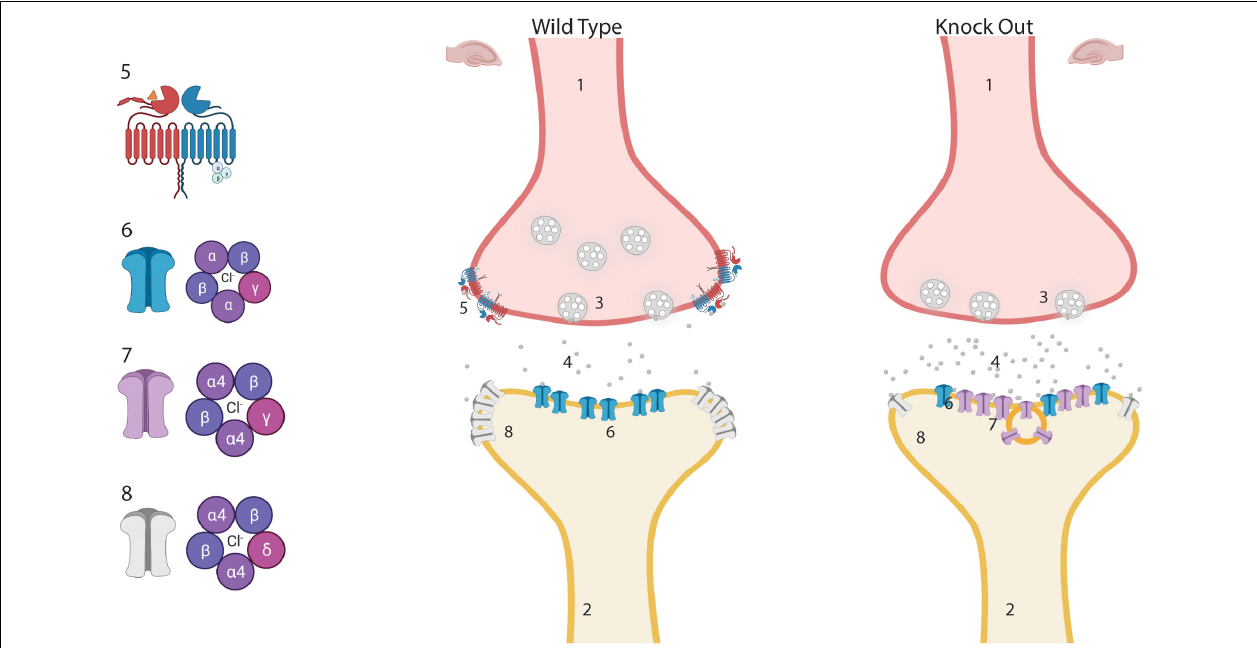
FIGURE 7 | Potential modification of inhibitory synapses in the hippocampus of GABA B ( 1 ) knock out (KO) mice. Lack of GABA B autoreceptor may produce an increase in the release of GABA from the presynaptic terminal. Chronically increased GABA may generate a downregulation of extrasynaptic α 4 βδ -GABA A receptors and upregulation of newly formed synaptic α 4 βγ -GABA A receptors that are less sensitive to GABA but sensitive to low alcohol concentrations. We hypothesized that the presence of α 4 β G 2 -GABA A Rs in the synaptic compartment may increase the preference for consuming alcoholic solutions. (1) Presynaptic terminal. (2) Postsynaptic terminal. (3) Synaptic vesicle. (4) Extracellular GABA. (5) GABA B receptor. (6) αβγ -GABA A synaptic receptors. (7) Newly formed synaptic α 4 β G 2 -GABA A receptor. (8) Extrasynaptic α 4 βδ -GABA A receptors. This Figure was created with “BioRender.com”